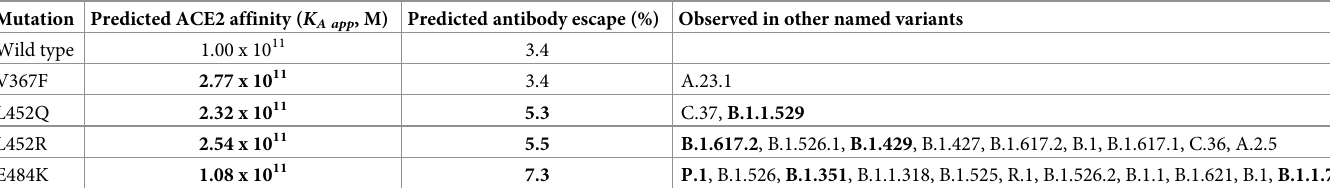
Table 3. Machine learning predictions of the impact of single RBD mutations on ACE2 affinity and human serum antibody escape. Mutation Predicted ACE2 affinity ( K A app , M) Predicted antibody escape (%) Observed in other named